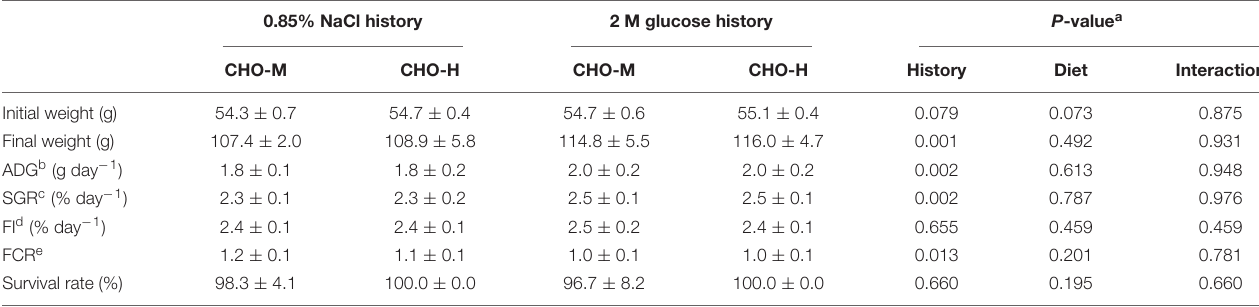
TABLE 5 | Growth performance of fish injected with saline (0.85% NaCl) and glucose (2 M) at 24 wpi after challenging with CHO-M and CHO-H for 4 weeks (mean ± SD, n = 6).